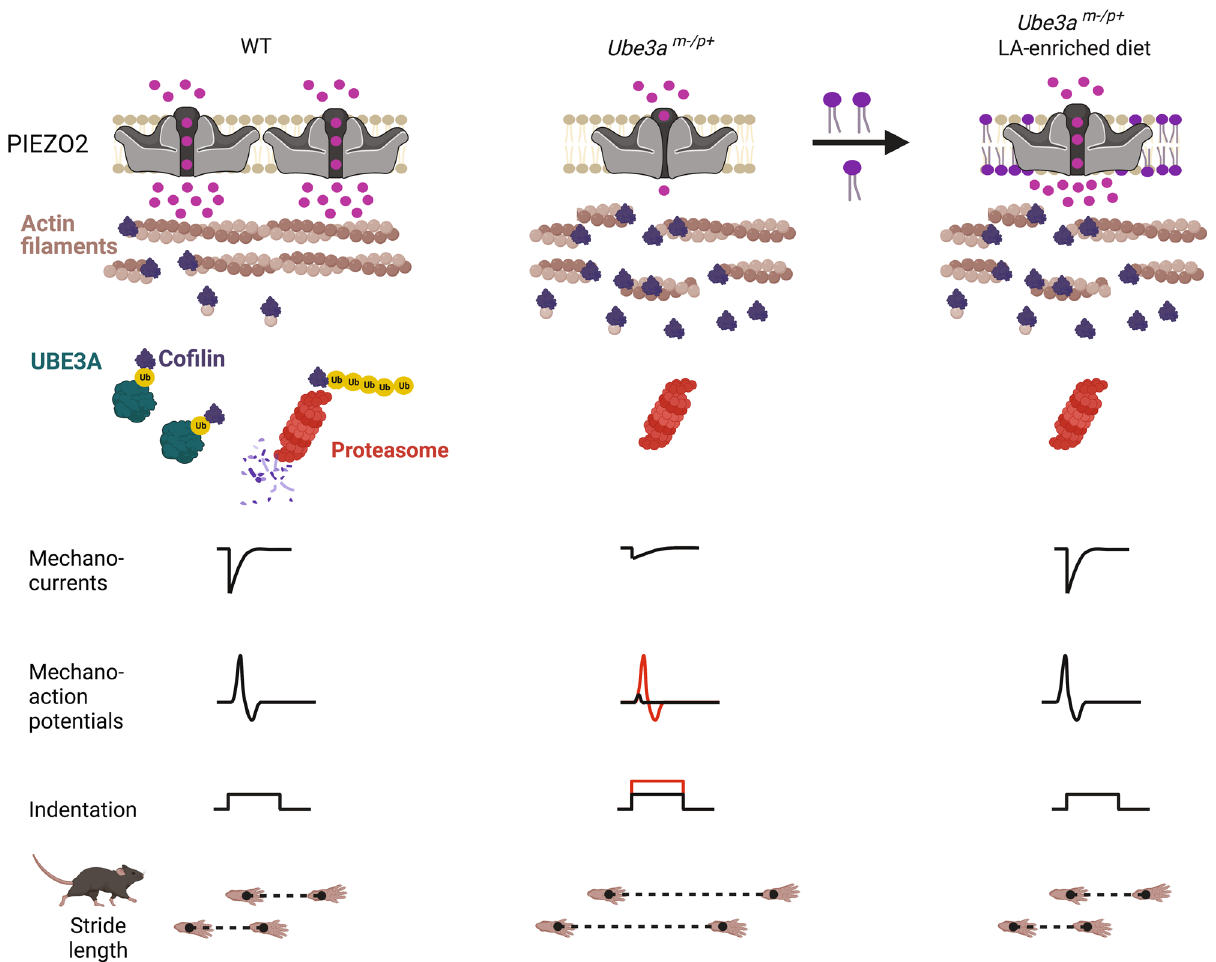
Fig. 10 | Proposed mechanism whereby lack of UBE3A decreases mechan- osensation in AS. Loss of Ube3a expression increases co fi lin leading to a decrease in actin fi laments. Reduced actin fi laments decrease PIEZO2 function as well as